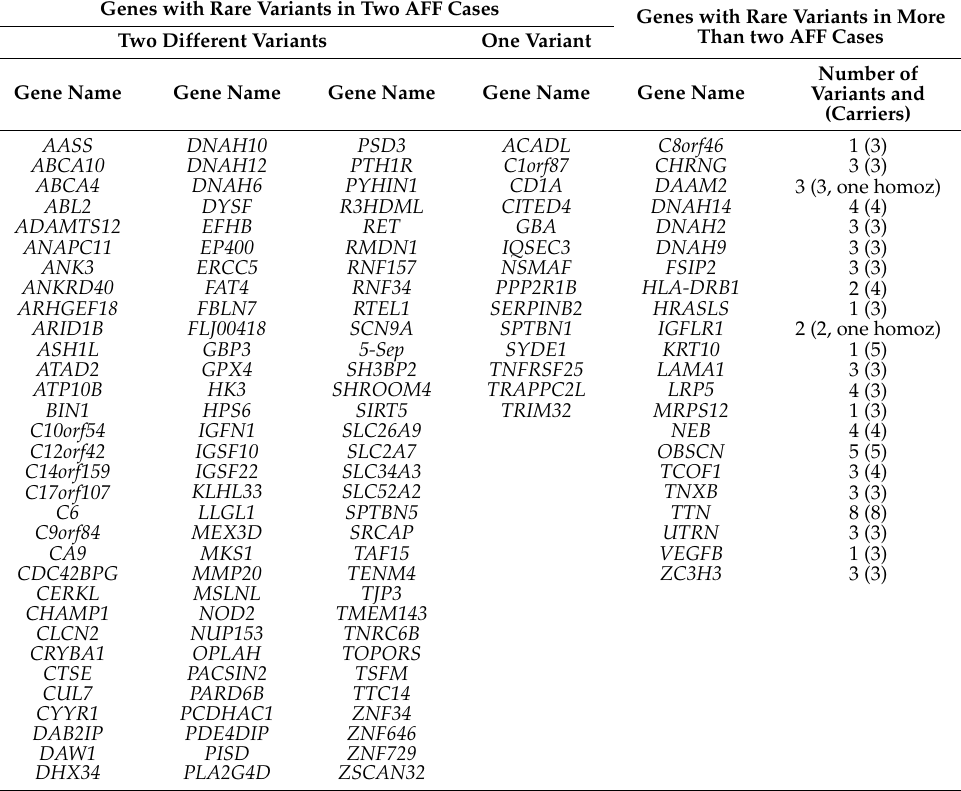
Figure 1. Pipeline of selected variants obtained by whole exome sequencing of 12 patients with BP-related AFF and 4 controls (individuals with long-term BP treatment without AFF). Only variants or genes mutated in at least two patients were considered for further analysis. Table 2. Genes with at least two individuals carrying a rare variant; Variants were prioritized based on functional prediction (excluding variants with CADD score <20, and those considered tolerated or benign by SIFT or PolyPhen_humDiv, respectively).